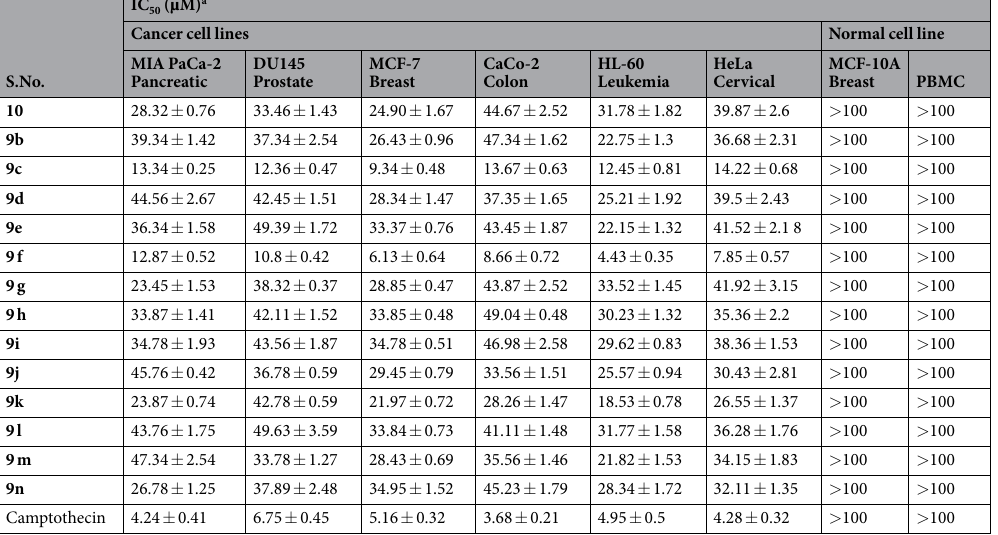
Table 2. Antiproliferative activities of saccharumoside-B and its analogs against various cancer and normal cell lines. a Data represented as mean of the three independent experiments ±